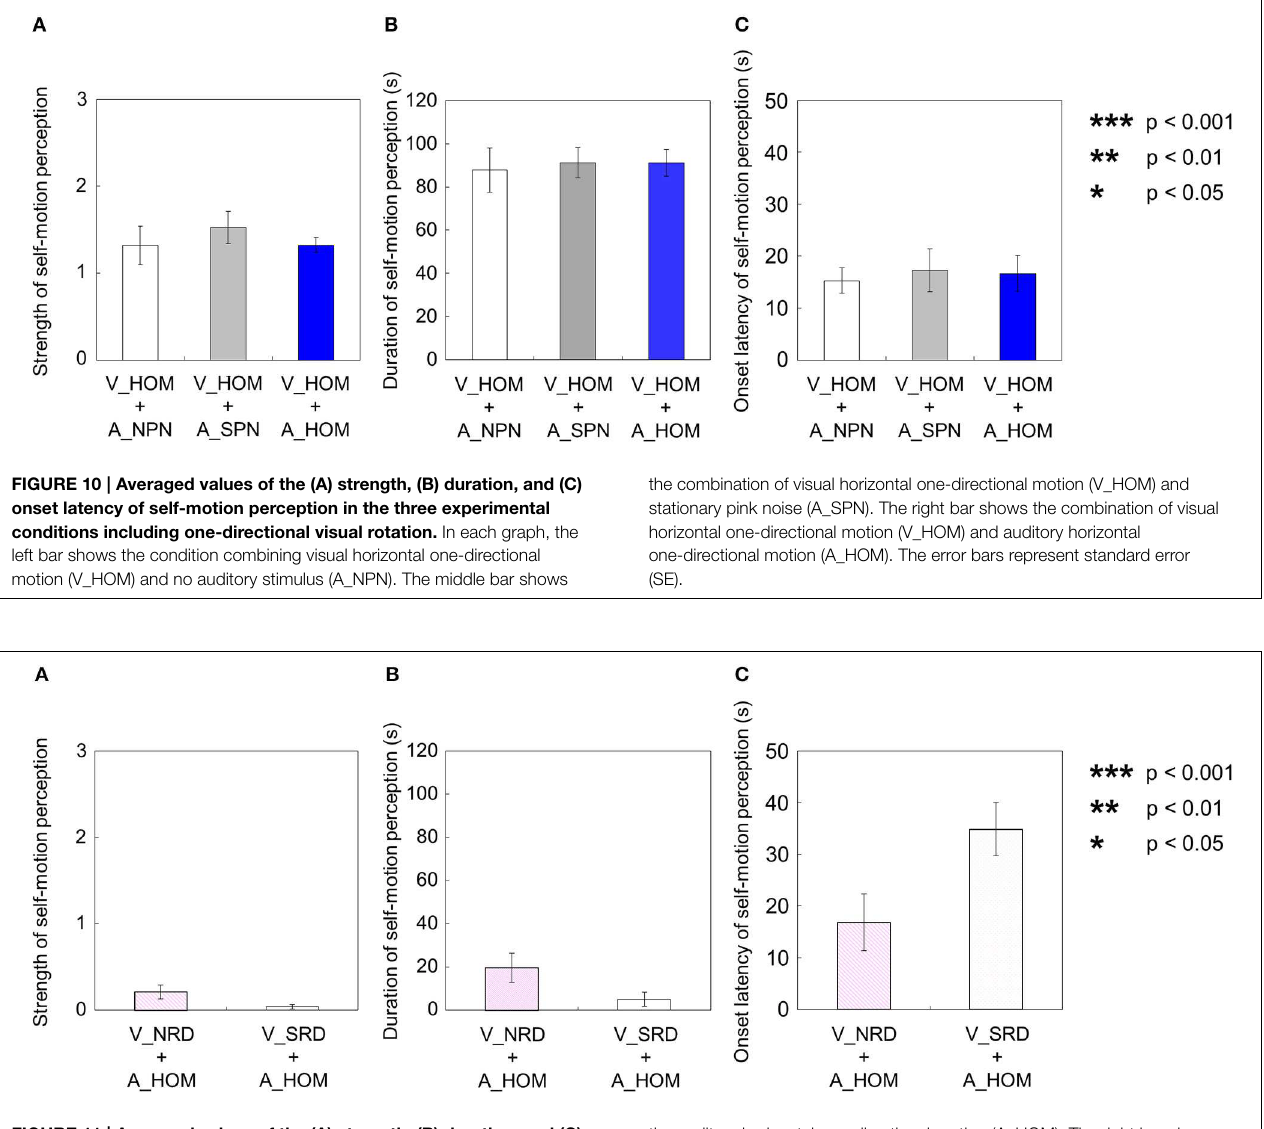
the auditory horizontal one-directional motion (A_HOM). The right bar shows the combination of the stationary random dot pattern (V_SRD) and the auditory horizontal one-directional motion (A_HOM). The error bars represent standard error